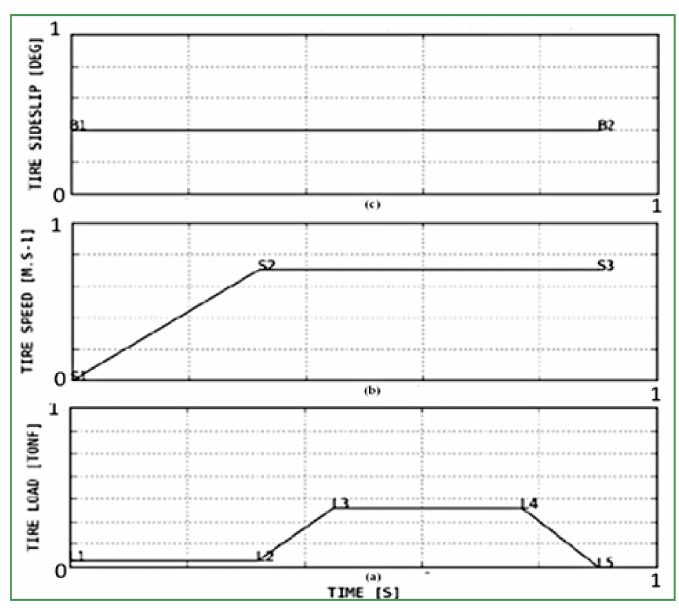
Figure 3. The test protocol. ( a ) loading steps, ( b ) velocity strategy, ( c ) skidding angle.